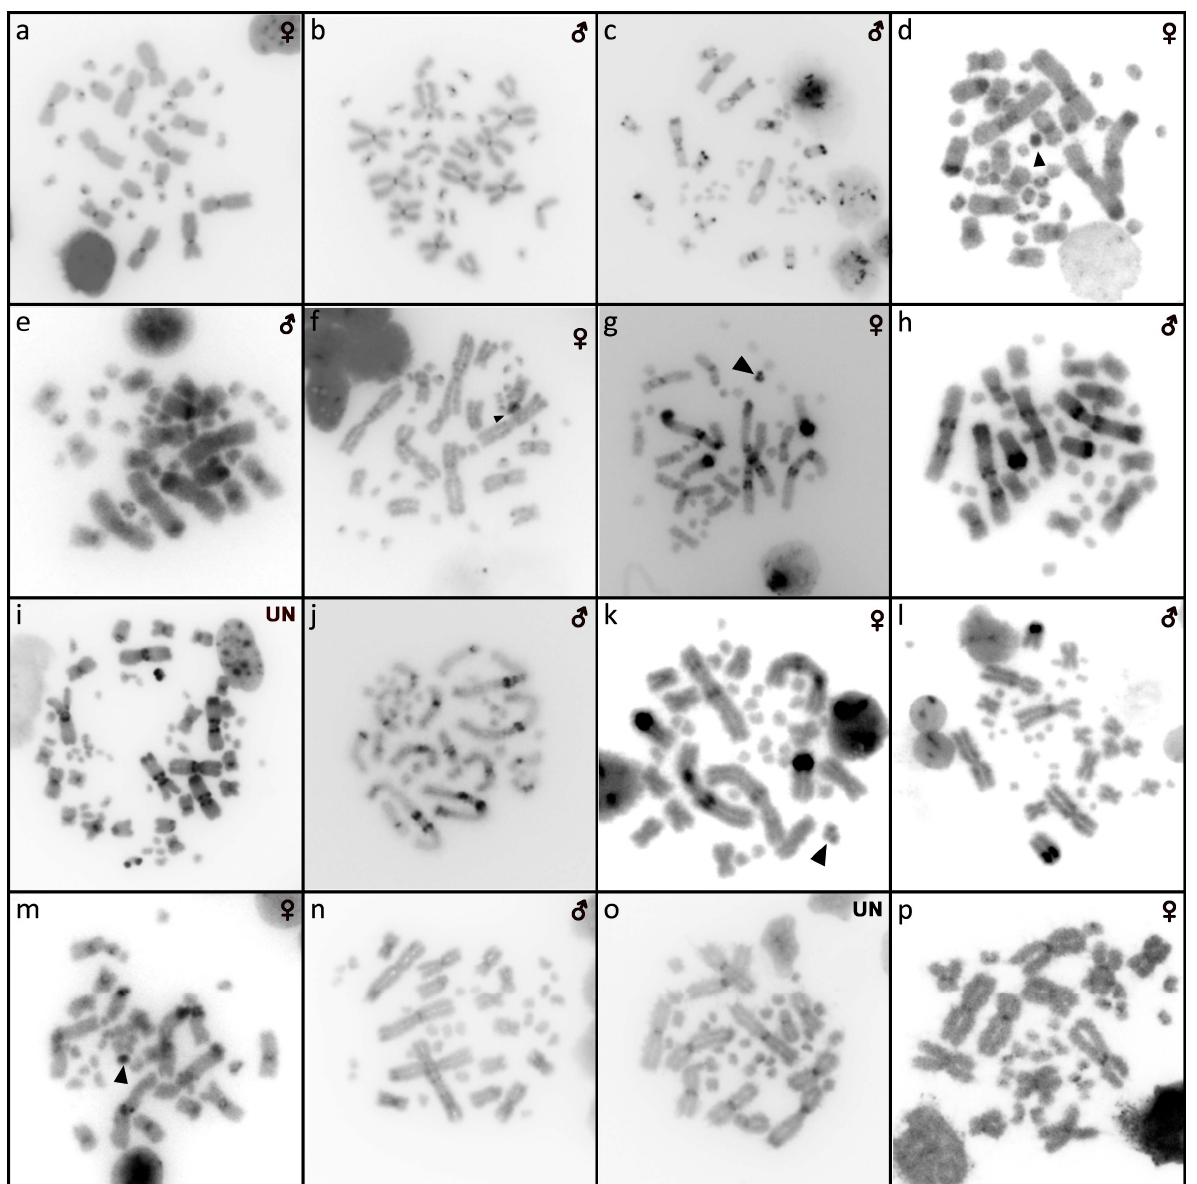
Figure 5. C-banded metaphases of Shinisaurus crocodilurus ( a , b ), Varanus auffenbergi ( c ), Varanus cumingi ( d , e ), Varanus kordensis ( f ), Varanus olivaceus ( g , h ), Varanus primordius ( i , j ), Varanus salvadorii ( k , l ), Varanus salvator komaini ( m , n ), Xenosaurus platyceps ( o ), and Xenosaurus rectocollaris ( p ). When visible, the W chromosomes are indicated by arrows. UN: sex not known.